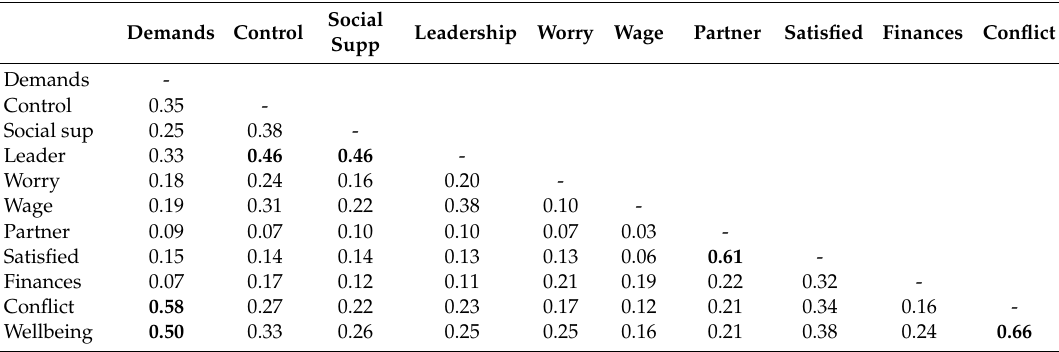
Table 3. Correlations between main variables